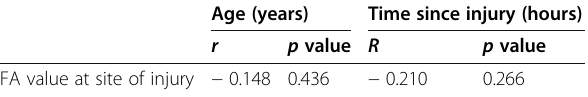
Table 6 Pearson correlation between age (years), time since injury (hours), and FA at the level of injury